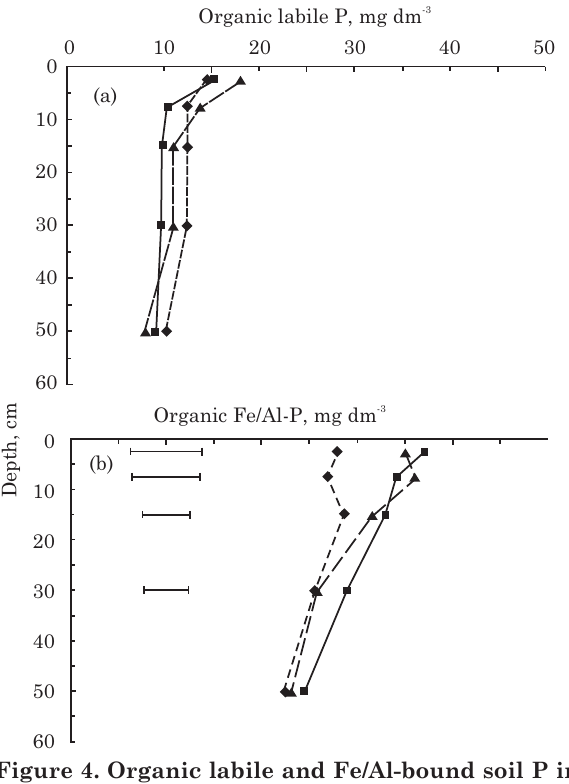
Figure 4. Organic labile and Fe/Al-bound soil P in the soil profile as affected by surface- broadcast P fertilizers. (a) Organic labile P; (b) Organic Fe/Al-bound P. Dotted line – No P; dashed line - natural reactive Arad phosphate; solid line – triple superphosphate. Horizontal bars show LSD (p<0.05), and compare treatments within each soil depth.